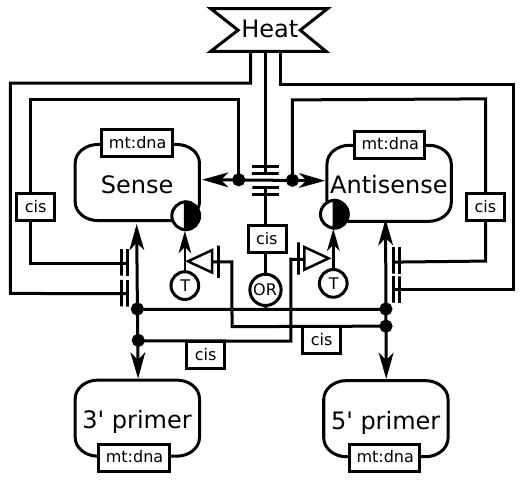
Figure A.9: Principle of the Polymerase Chain Reaction.